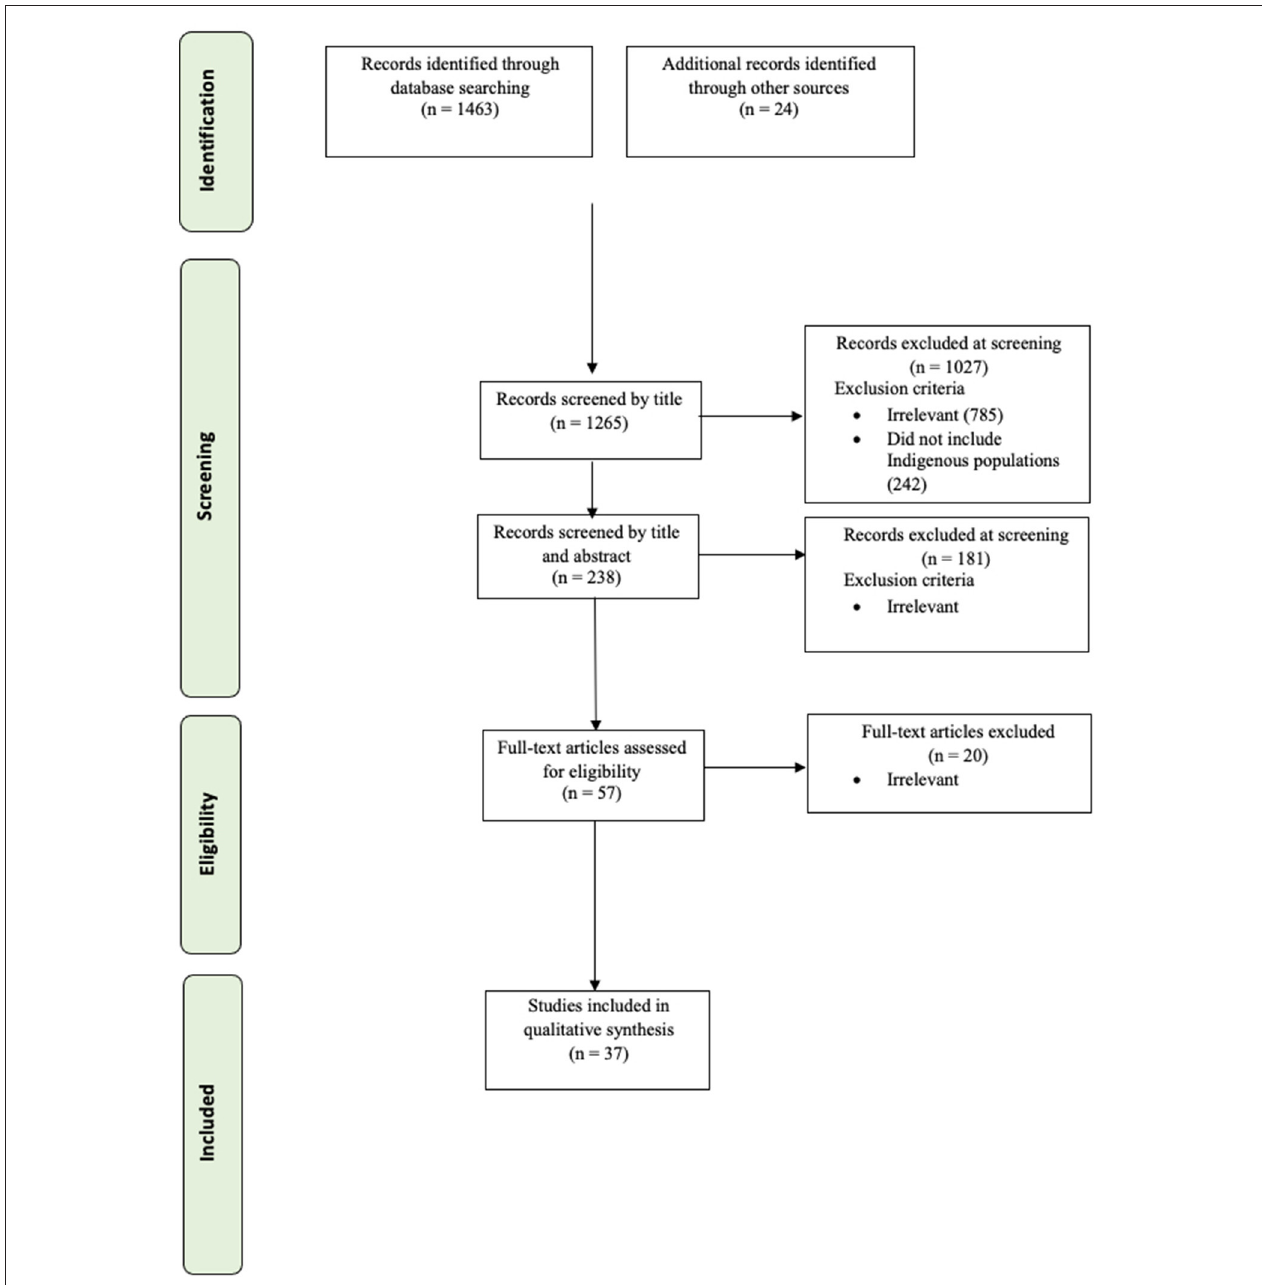
FIGURE 2 | A PRISMA flow diagram showing the steps for the scoping